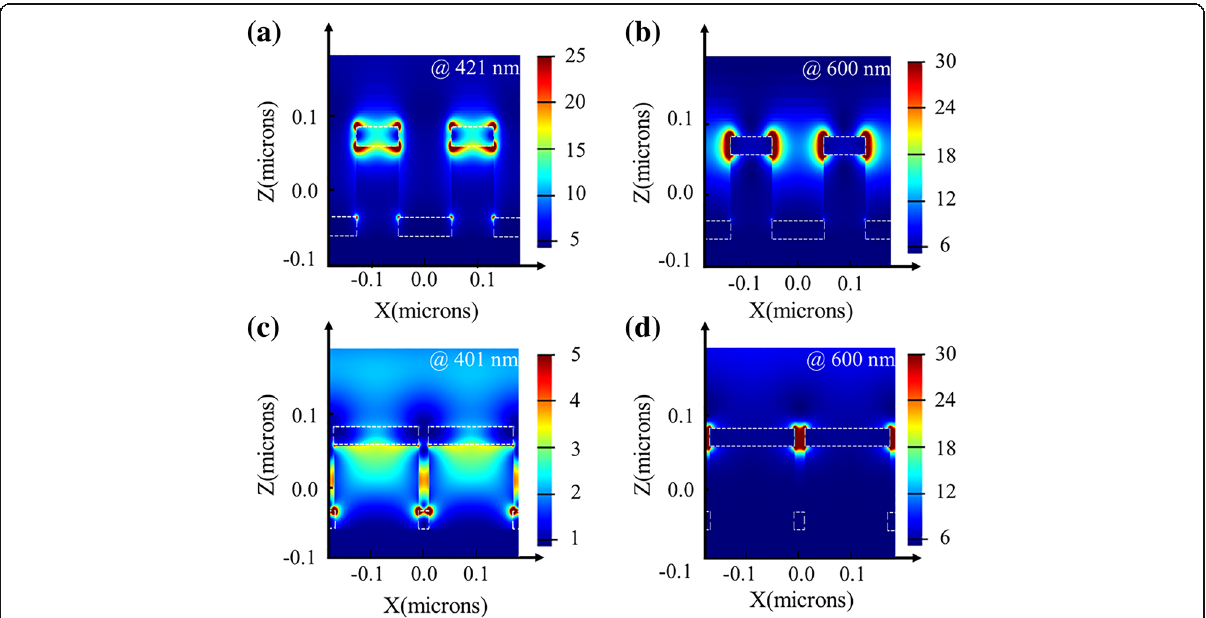
Fig. 3 Distribution of the electric field (| E| 2 ) in the XZ plane for the structure with a , b D = 80 nm, P = 180 nm, and c , d D = 160 nm, P = 180 nm. a , c Illuminated at the reflection valleys. b , d Both illuminated at the long incident wavelength of 600nm. The white dashed lines are the boundaries of the Ag